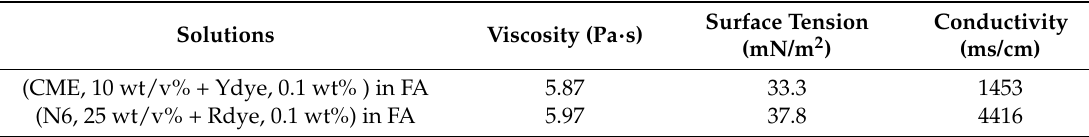
Table 1. Properties of the electrospinning